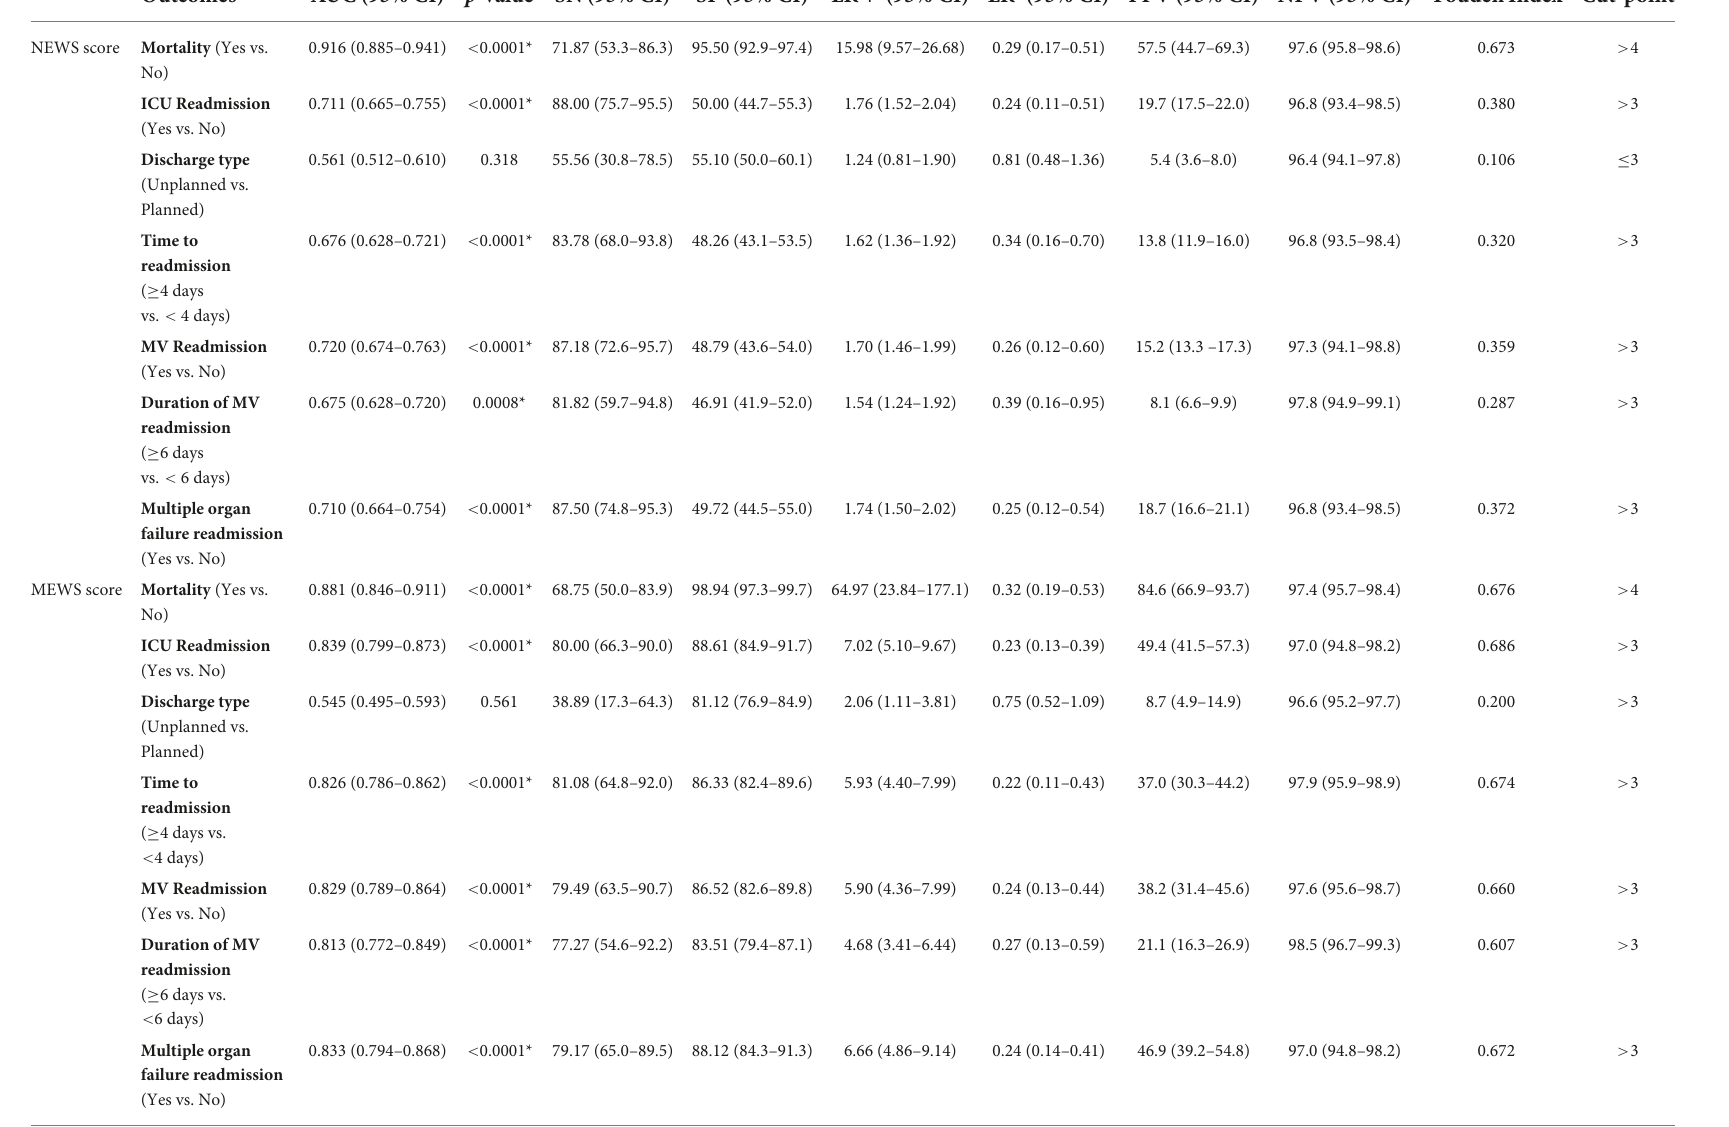
TABLE 6 Receiver operating characteristic curve results of NEWS and MEWS scores to predicting outcomes.